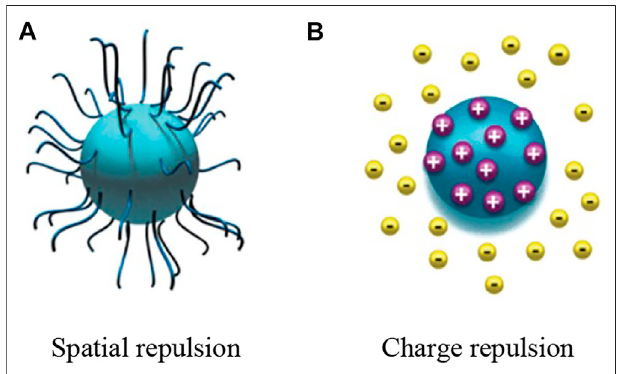
FIGURE 1 | Types of repulsion forces acting on nanoparticles. (A) Spatial repulsion (B) Charge